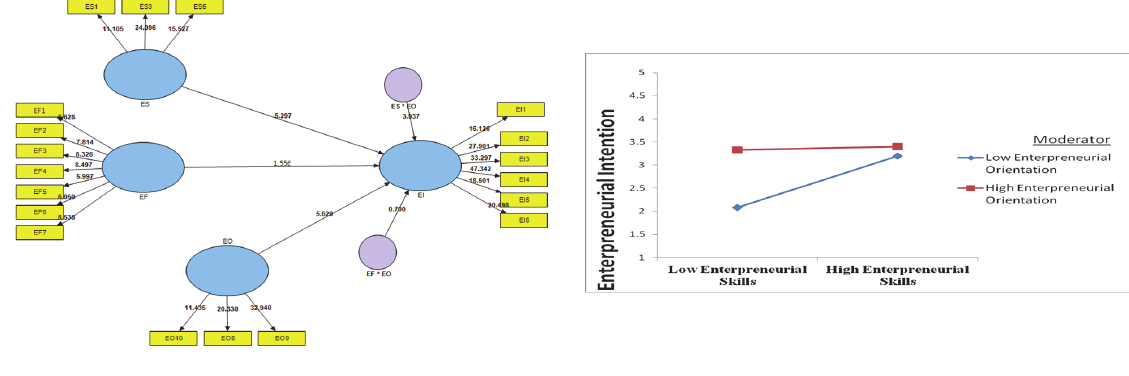
Fig. 1. Structural Model Fig. 2. Interaction